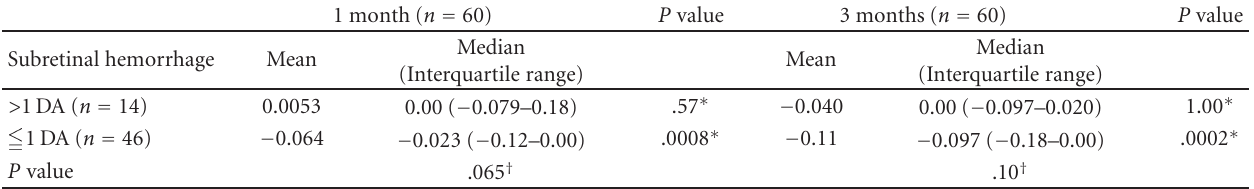
Table 3: Changes in the BCVA from baseline after IVR treatment in the patients having subretinal hemorrhage before treatment. 1 month ( n =